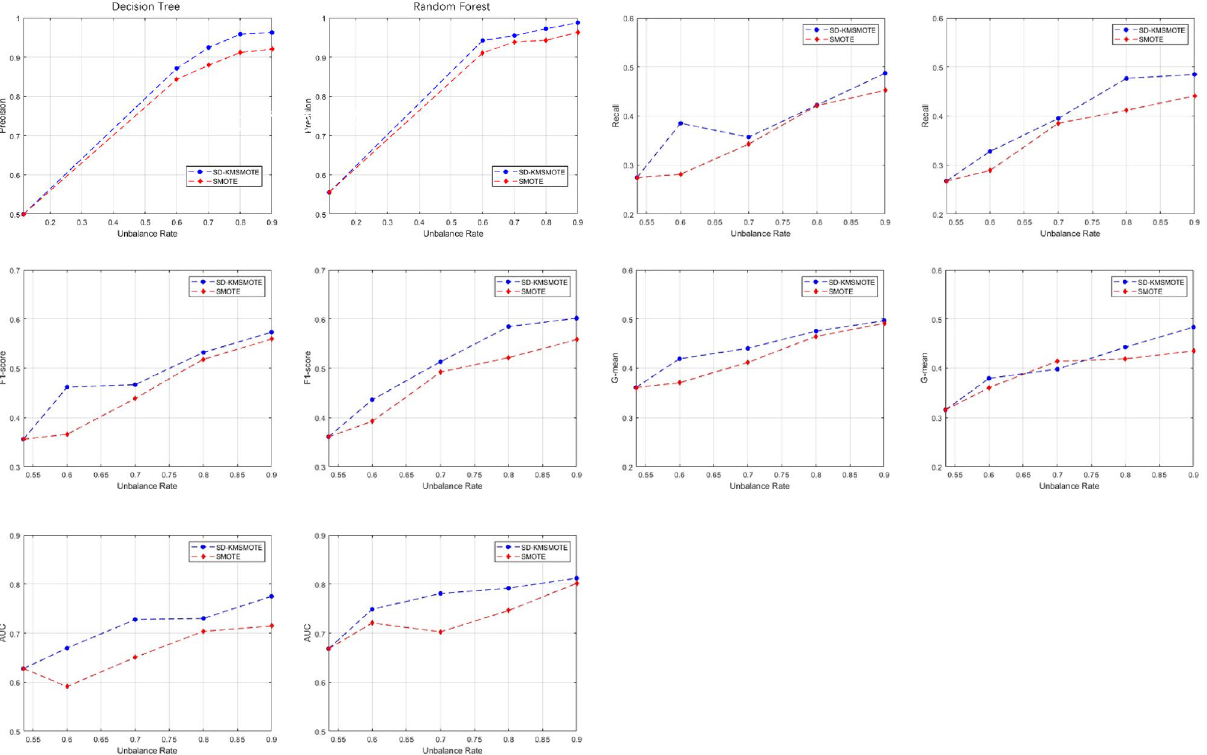
Figure 3. Comparison of evaluation indexes of Pima under different equilibrium